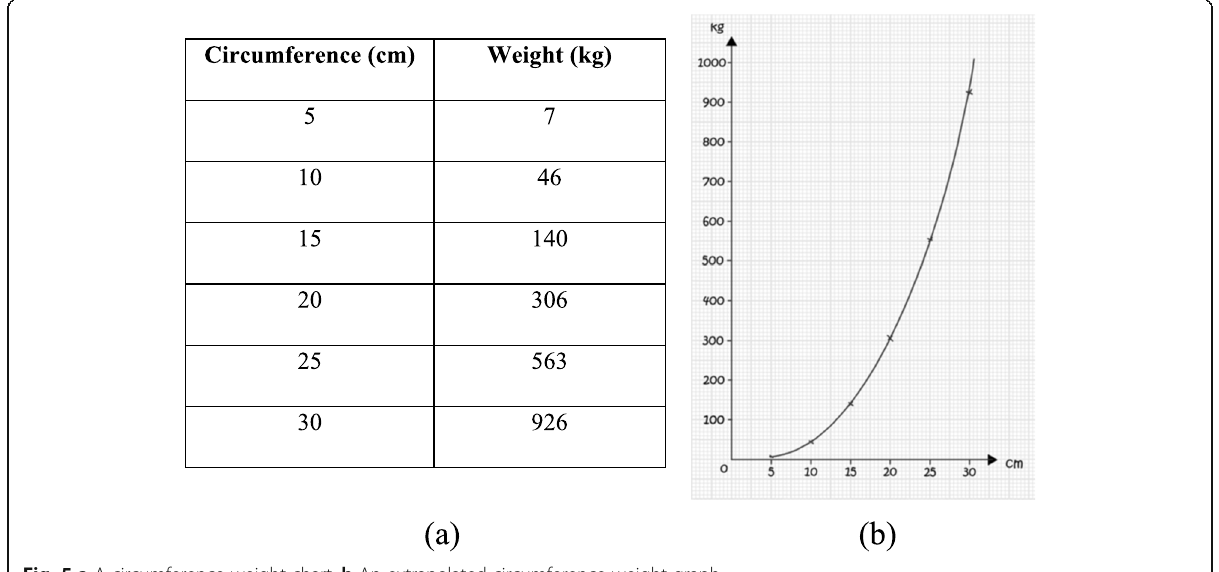
Fig. 5 a A circumference-weight chart. b An extrapolated circumference-weight